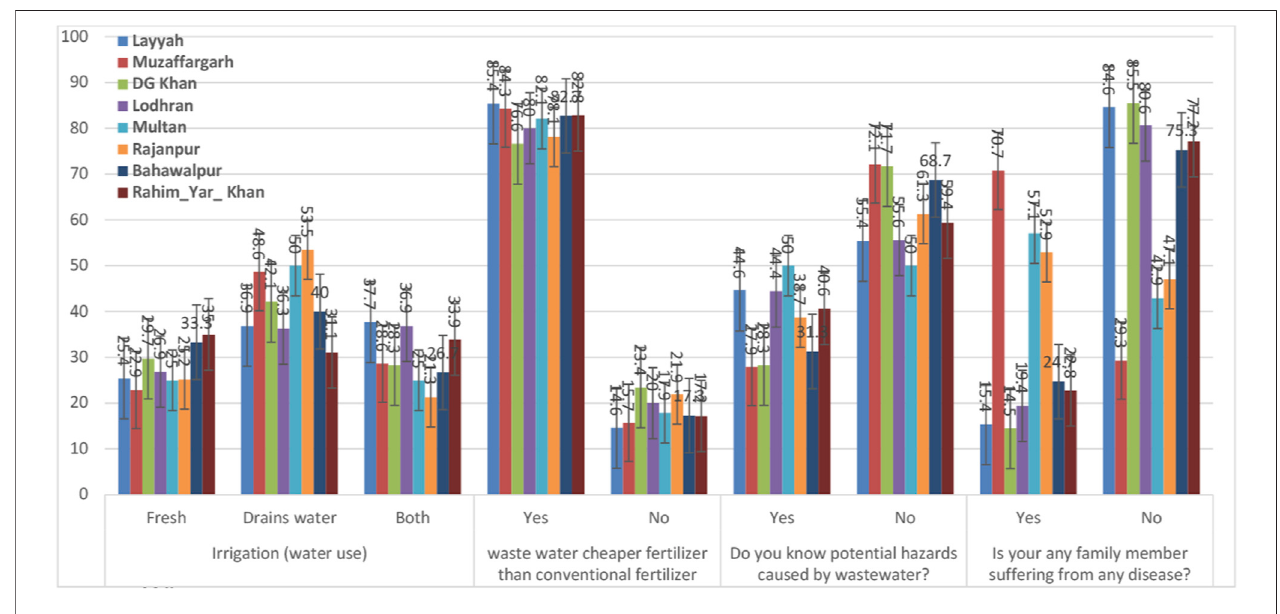
FIGURE 2 | Wastewater use for irrigation